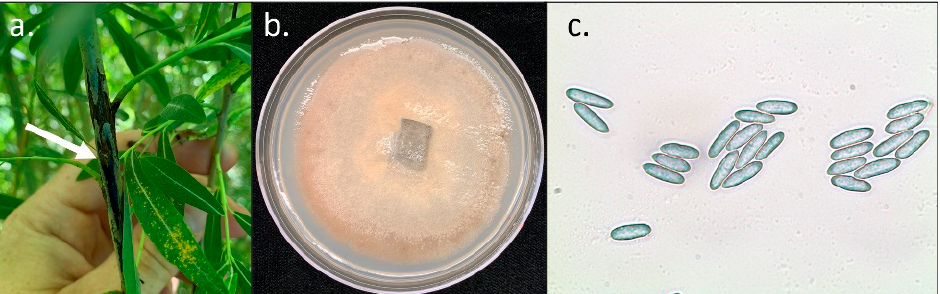
Figure 2. Photo of stem cankers without uredospore sporulation and fungal isolate of C. salicis . ( a ) Image of black canker in the 2013 Family Selection Trial ( b ) Image of isolated Colletotrichum salicis on potato dextrose agar. ( c ) Micrograph of C. salicis spores stained with cotton blue taken at 40× with a compound microscope.